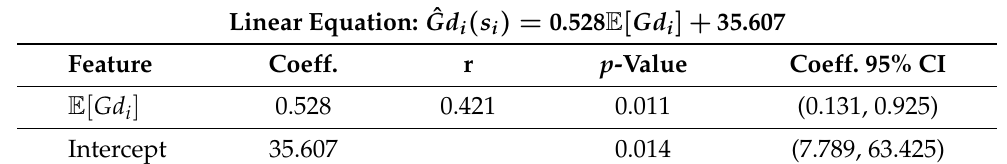
Table 15. OLS regression—random student’s Grades against Discussion’s Grade averages.